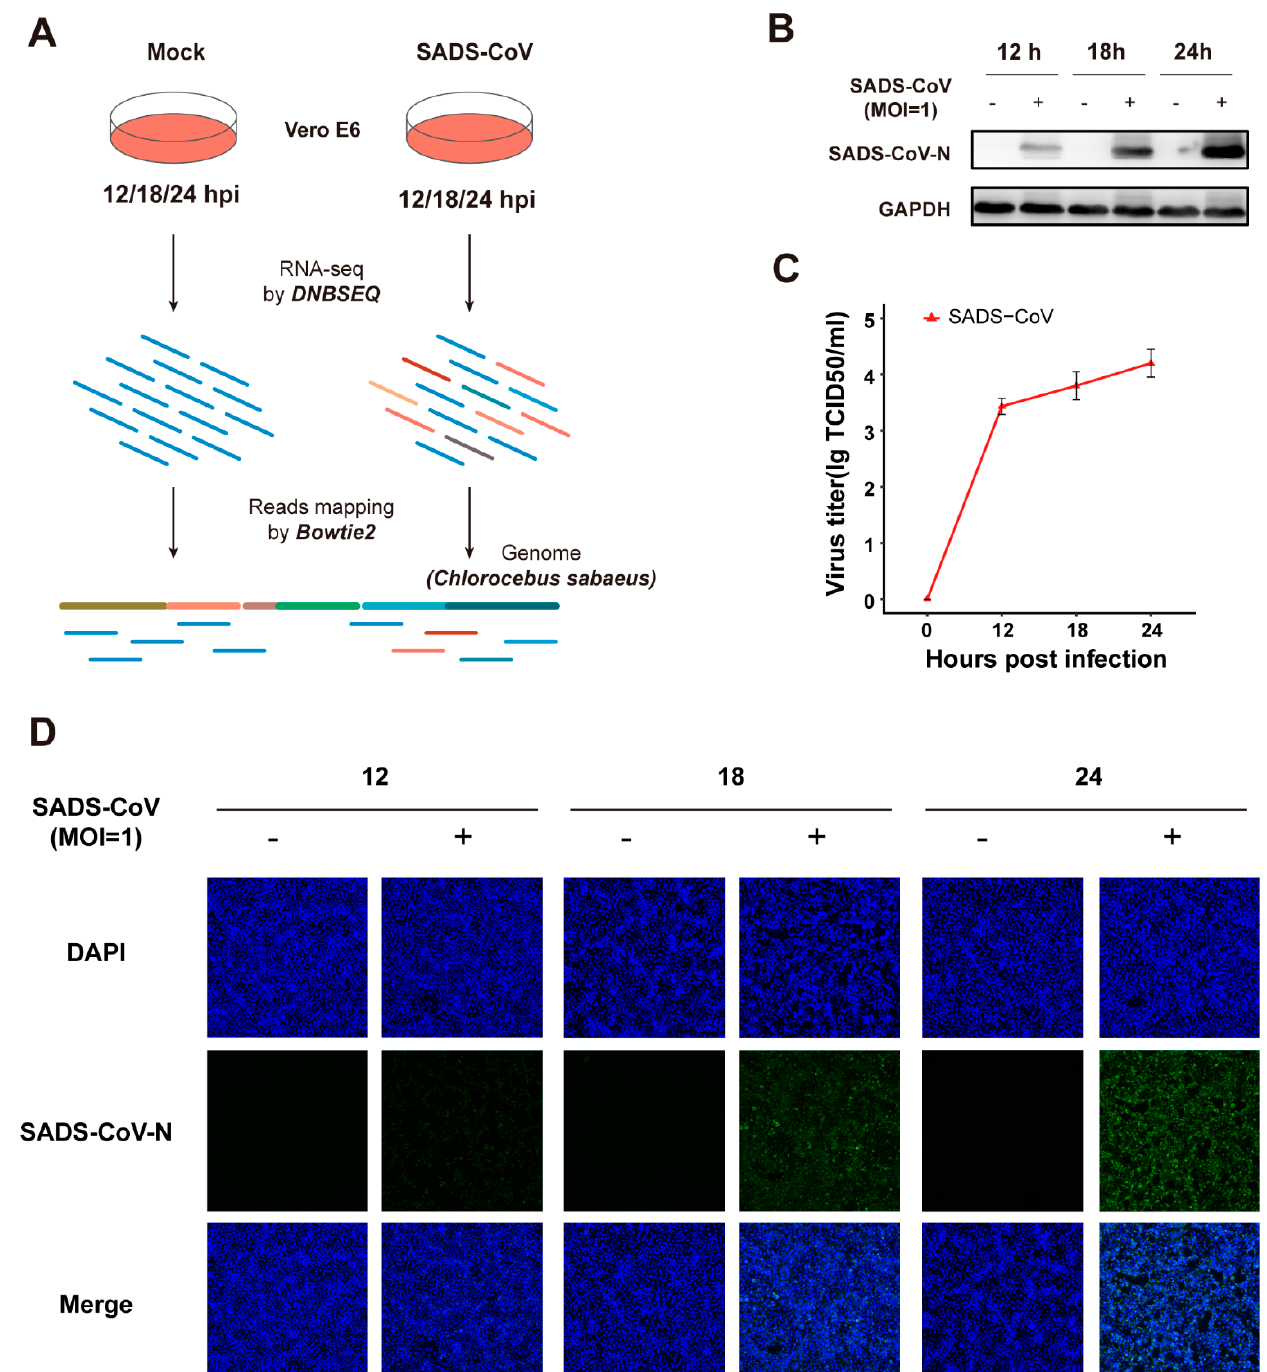
Figure 1. Workflow and confirmation of productive swine acute diarrhea syndrome coronavirus (SADS-CoV) infection in cultured Vero E6 cells. ( A ) Workflow. Vero E6 cells were mock-infected or infected with SADS-CoV strain GDS04 (MOI = 1), followed by sample collection at 12, 18, 24 hpi. Samples from each group were prepared in triplicate. Total RNA was extracted and BGI DNBSEQ RNA-sequencing was performed. ( B ) Western blot confirmation via viral N-protein in SADS-CoV-infected Vero E6 cells. Cells were fixed at 12, 18, or 24 hpi, and N protein was detected by Western blot; GAPDH was conducted as an internal control gene. ( C ) The virus titer of SADS-CoV in Vero E6 cells was measured by TCID 50 . ( D ) Immunofluorescence staining of the viral N-protein in SADS-CoV-infected Vero E6 cells. Cells were fixed at 12, 18, or 24 hpi, and N protein (green) was detected by indirect immunofluorescence assay. Nuclei (blue) were shown by 4 ′ ,6-diamidino-2-phenylindole (DAPI) staining. The images of cells were acquired by a fluorescence microscope (Nikon) at a 40 ×